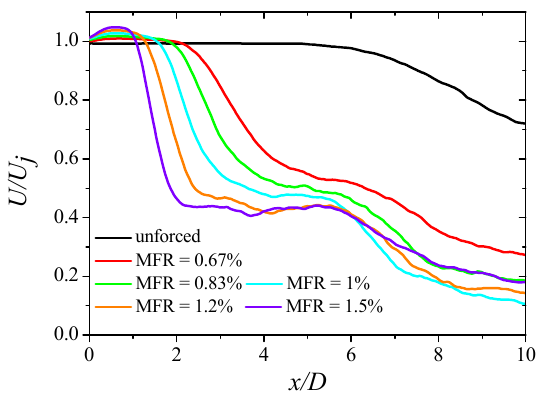
Figure 7. Velocity decay metric U * for different amplitudes.